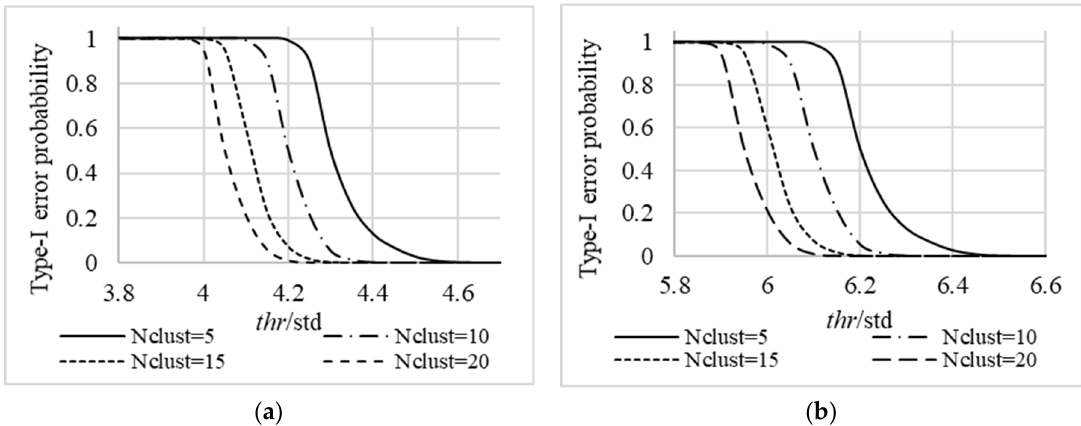
Figure 16. Probability of making a type-I error at different N clust for uncorrelated ( a ) and correlated ( b ) stationary noise.